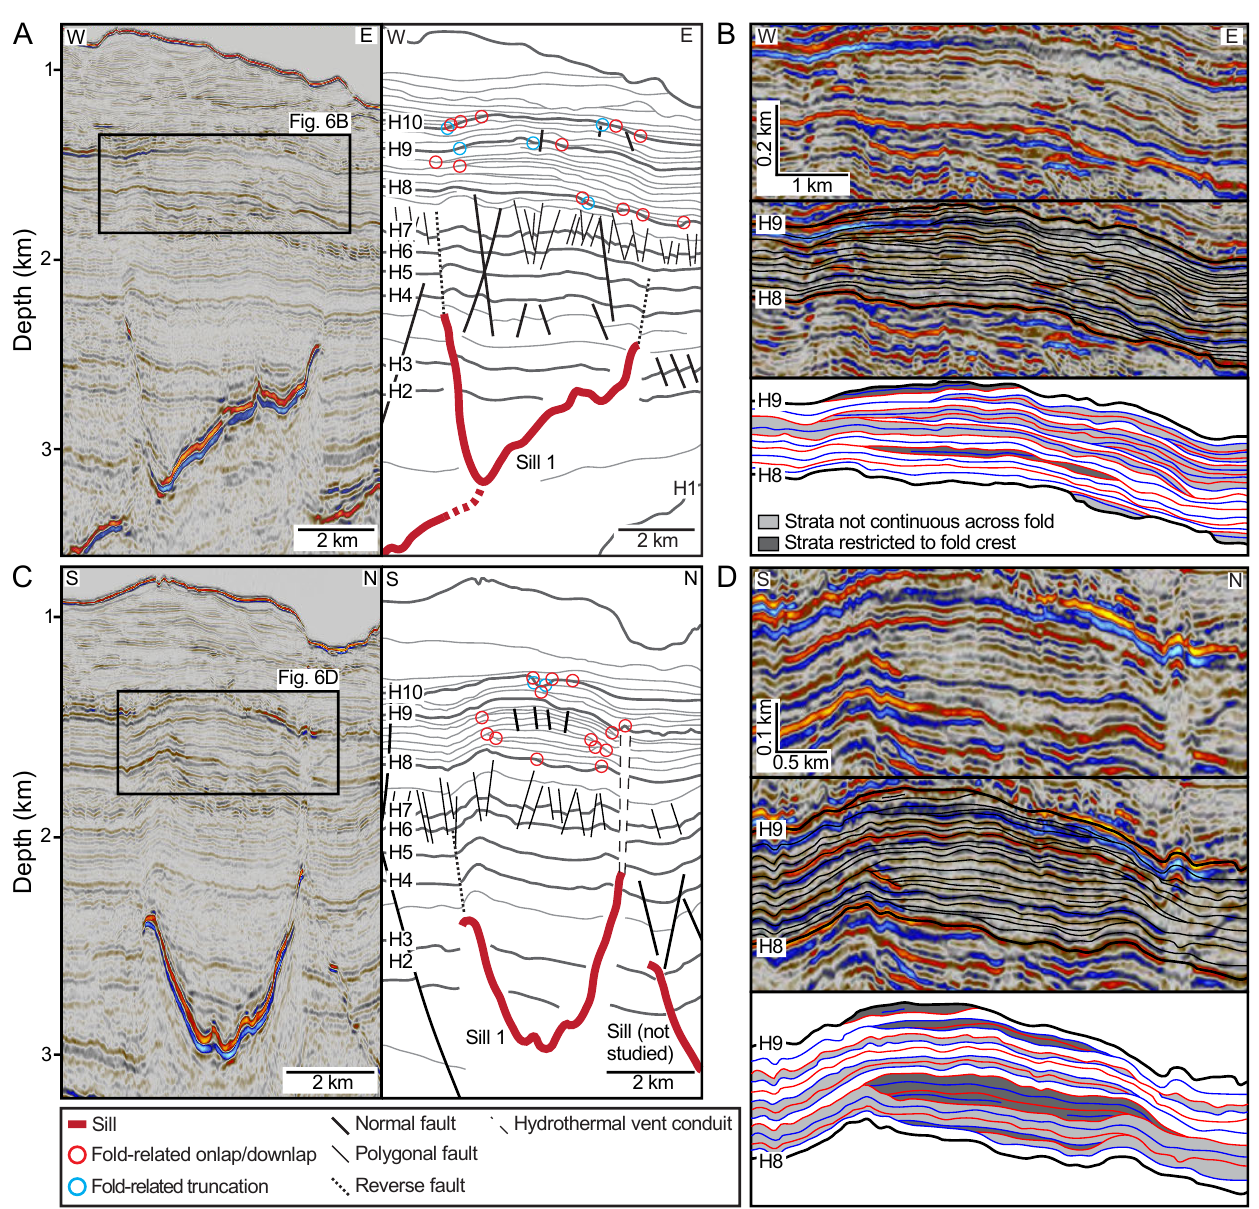
Figure 6: Seismic sections and line interpretations through S1 and Fold 1. See Figure 5 for